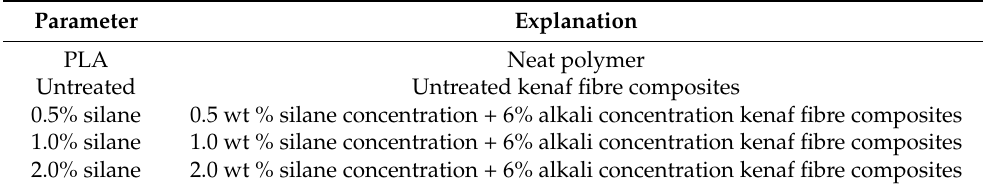
Table 2. Sample classification.